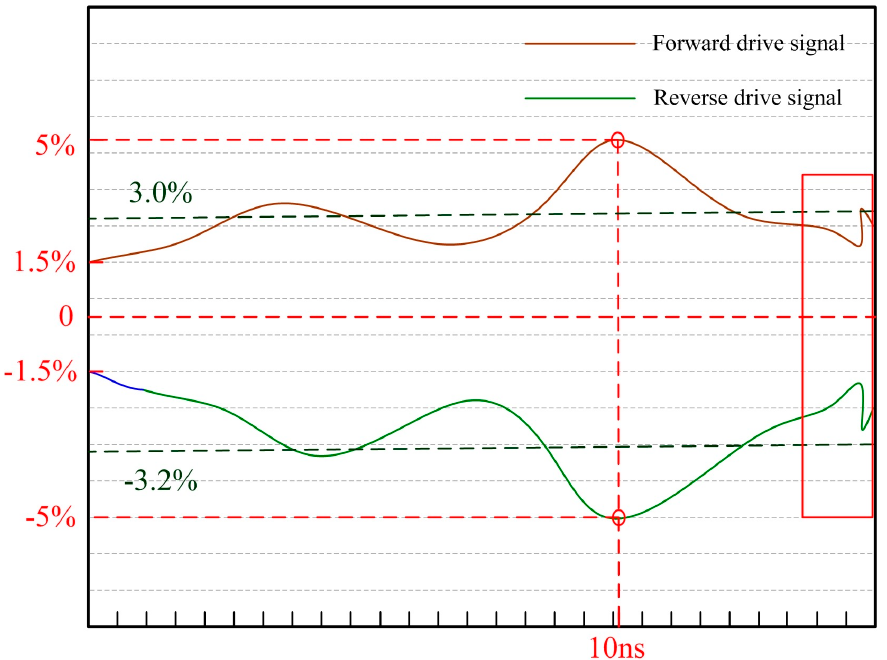
Figure 22. Variation curve of the r Δ i curve on the forward/reverse driving signals.